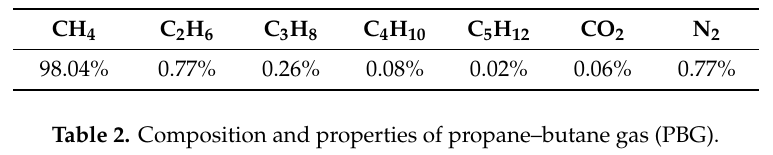
Table 1. Composition of natural gas (NG) in % vol.